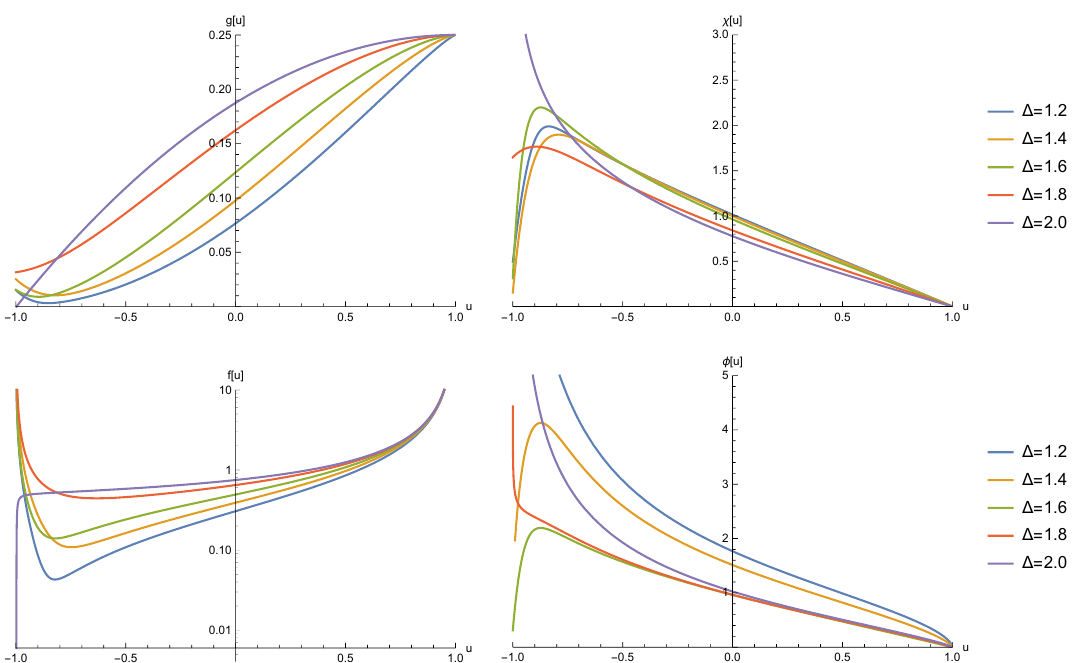
Figure 5 . Numerical plots of non-singular solutions of g ( u ) , χ ( u ) , f ( u ) and φ ( u ) with ∆ = ∆ + for various dimensions in the range of 1 . 2 ≤ ∆ 2 . 0 . At least, adjusting the values of α , we can find + ≤ a non-singular solution for a wide range of non-irrelevant dimension ∆ . Here we took α = 2 . 101 (for ∆ = 1 . 2 ), α = 2 . 083 (for ∆ = 1 . 4 ), α = 1 . 962 (for ∆ = 1 . 6 ), α = 1 . 663 (for ∆ = 1 . 8 ) and α = 1 . 414 (for ∆ = 2 . 0